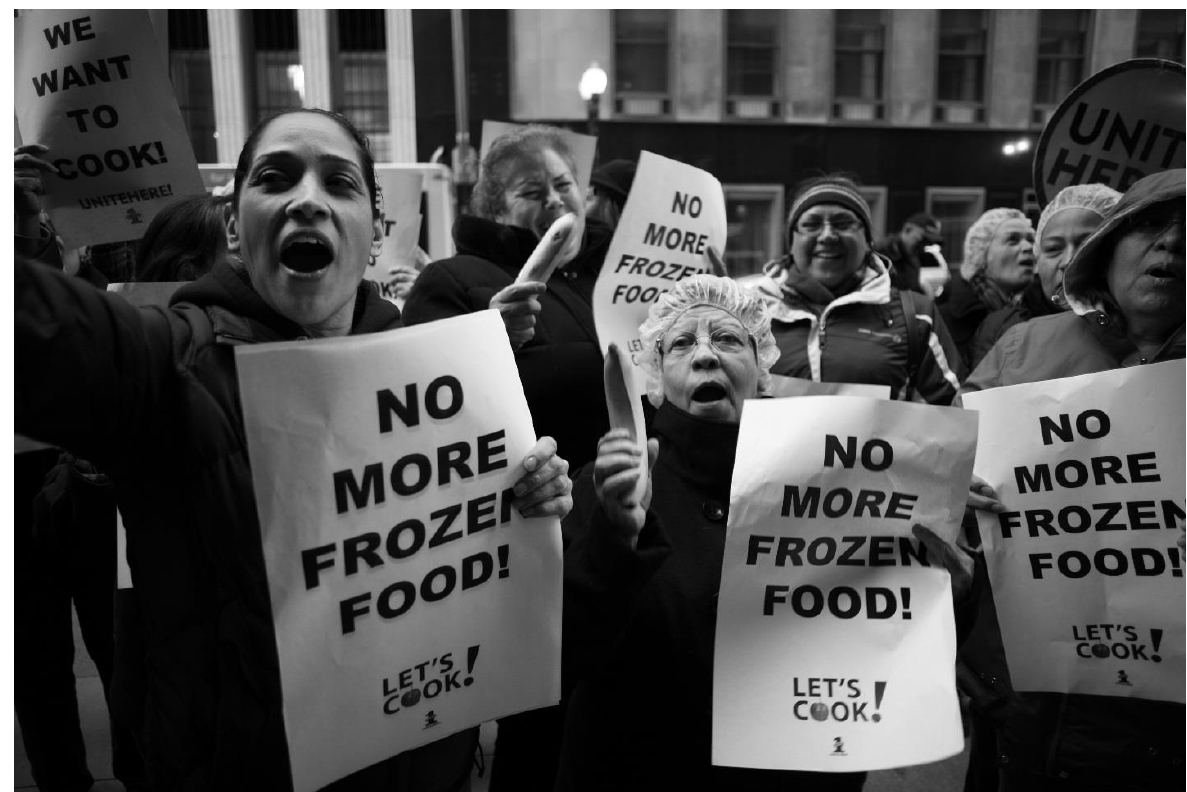
FIGURE 1: UNITE HERE LOCAL 1 PROTEST IN